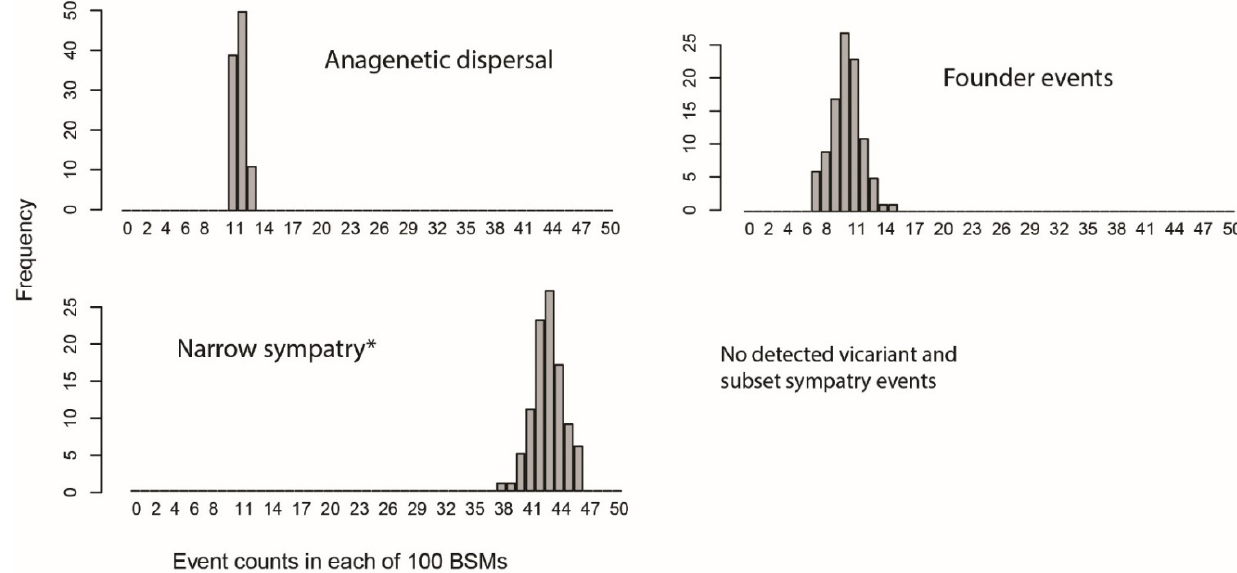
Figure 6. Histogram of event counts from biogeographic stochastic mapping in BioGeoBEARS. Note that * should be interpreted with caution due to experimental design with two areas. The area classified as “Other” is extremely wide and would produce a false positive score under narrow sympatry.